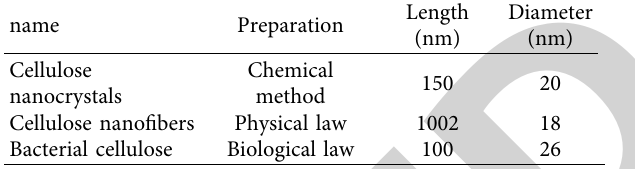
Table 1: Classification of nanocellulose.